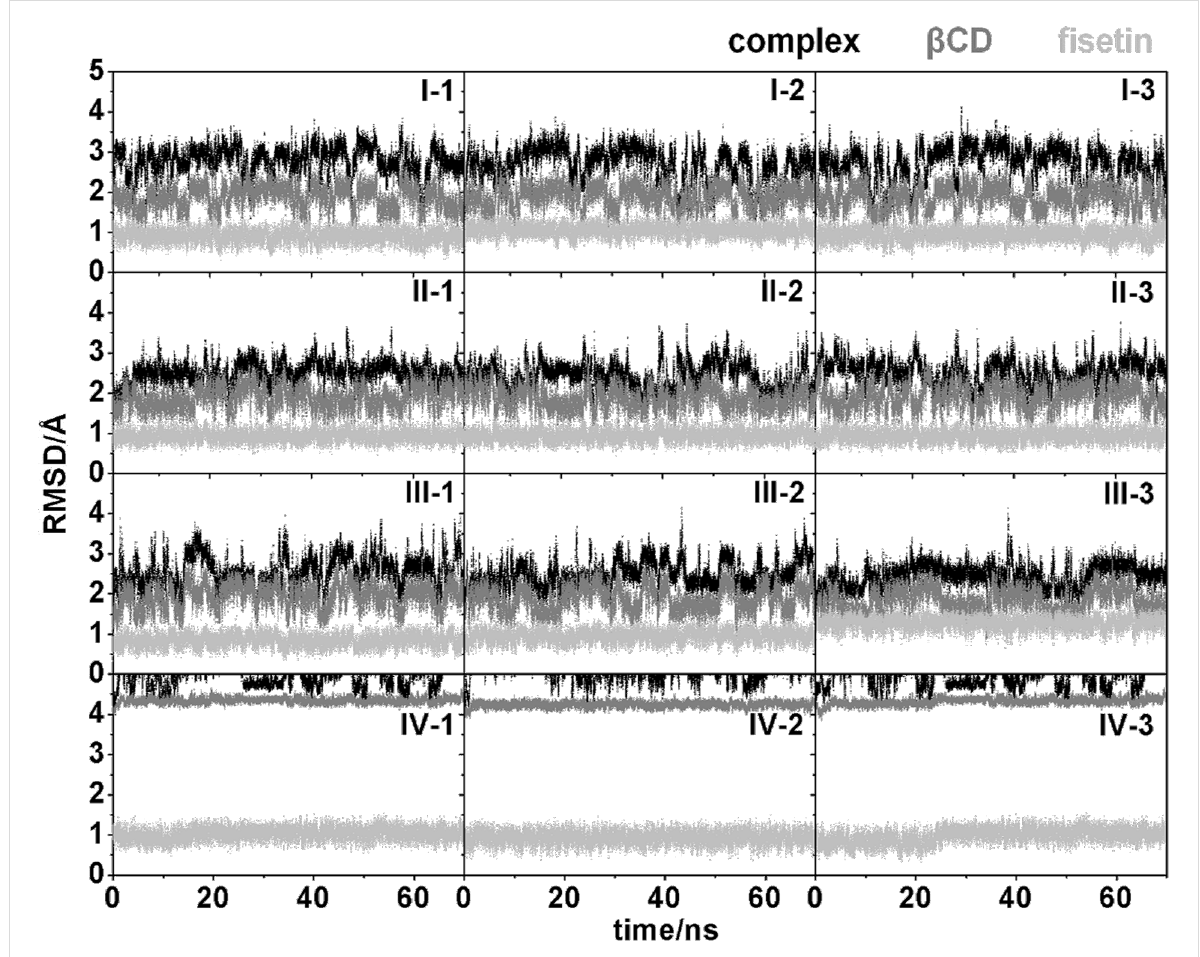
Figure 4: RMSD plots of all atoms in inclusion complex (black), β -CD (dark grey) and fisetin (light grey) for the twelve simulated systems of complexes I–IV .